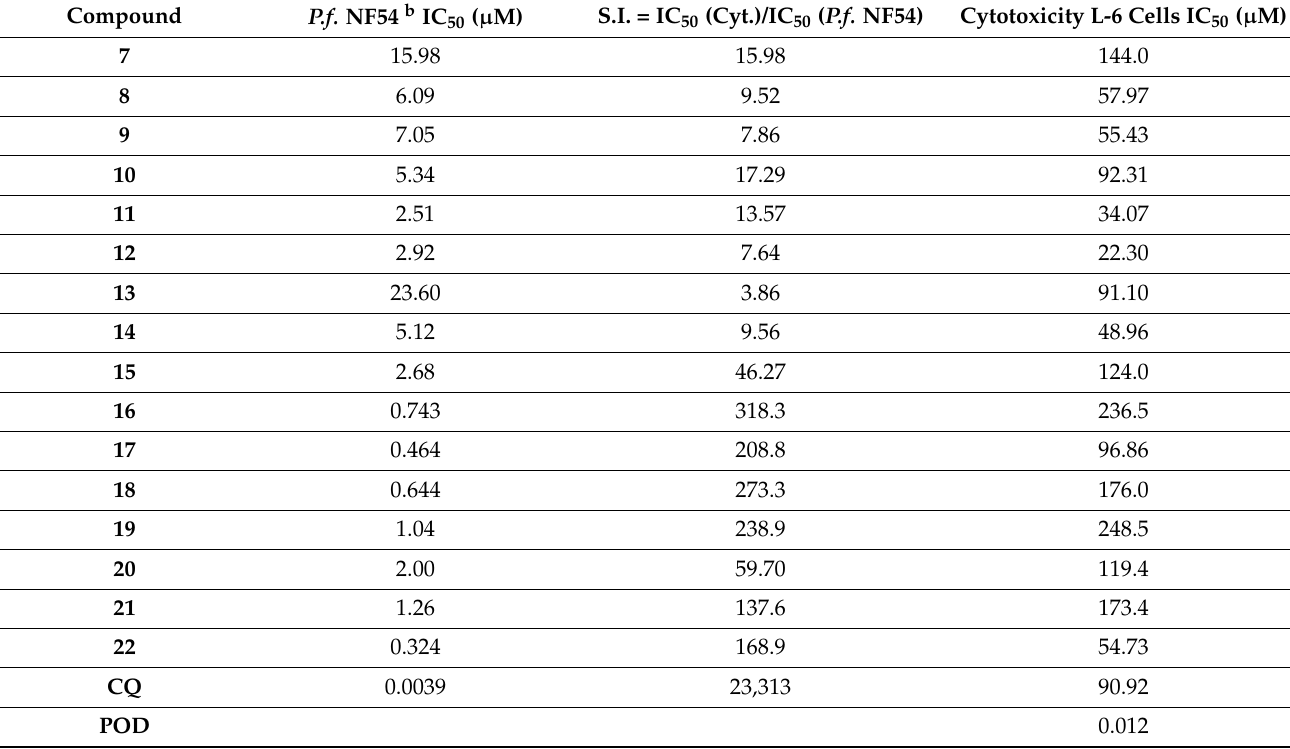
Table 1. Activities of compounds 7 – 22 against P. falciparum NF54, and L-6 cells, expressed as IC 50 ( µ M) a .